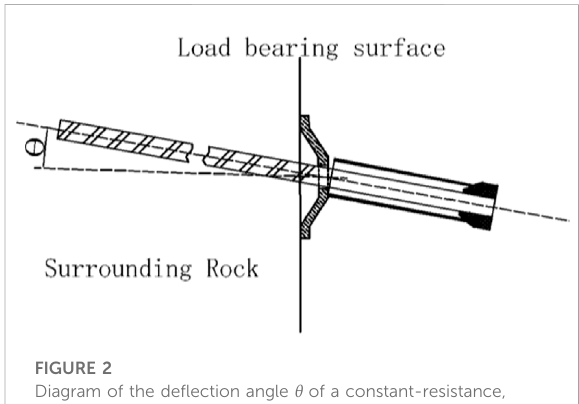
FIGURE 2 Diagram of the de fl ection angle θ of a constant-resistance, energy-absorbing, and anti-scouring bolt.